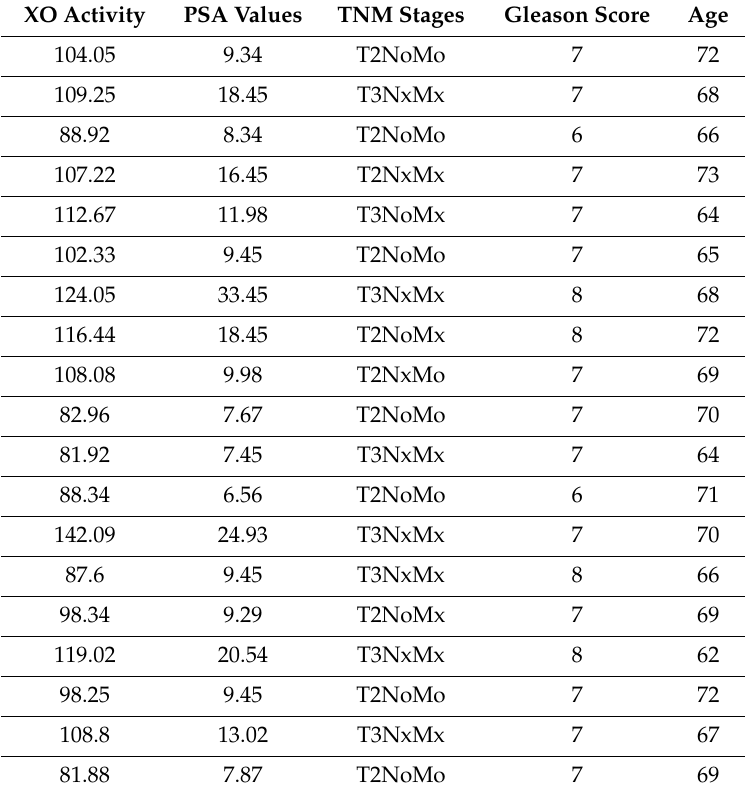
Table A1. XO activity case versus the matched PSA level, Gleason scores, TNM stages, and ages. XO Activity PSA Values TNM